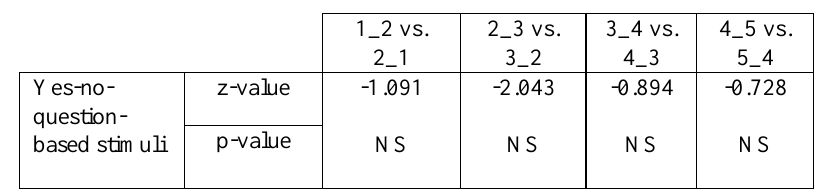
Table VII. z- and p-values of four Wilcoxon matched pairs signed rank tests comparing the “different” response rate between two conditions (AB order and BA order) for each pair of yes-no-question-based